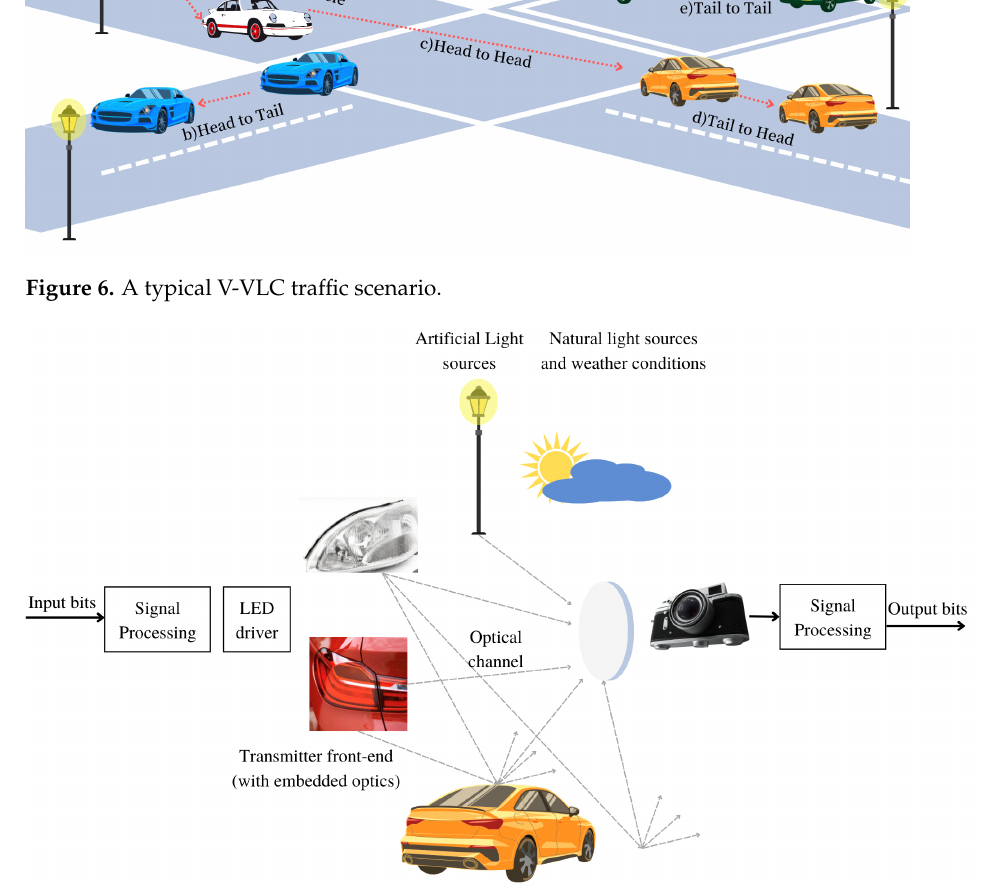
Figure 7. Building blocks of a generic V-VLC